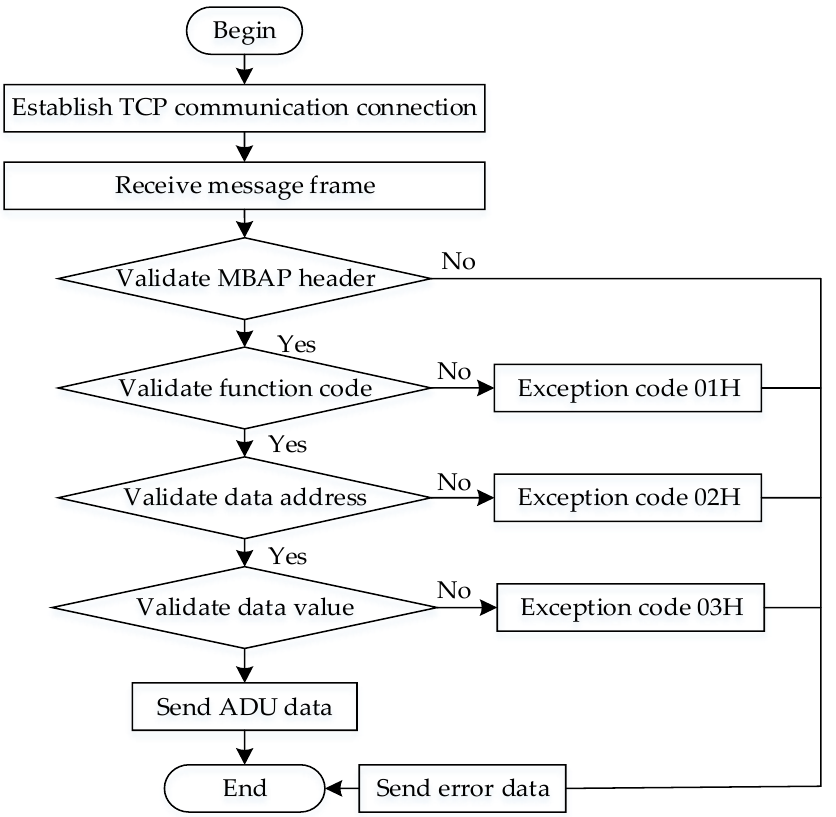
Figure 6. The judgment process of Modbus TCP data.